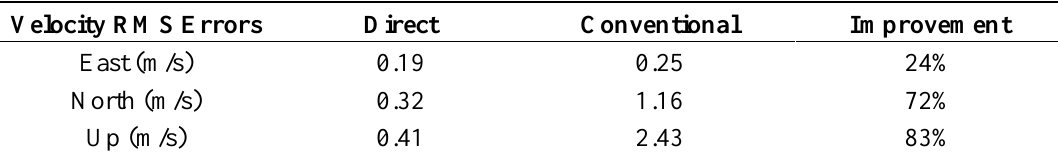
Table 2. Velocity RMS errors–indoor scenario